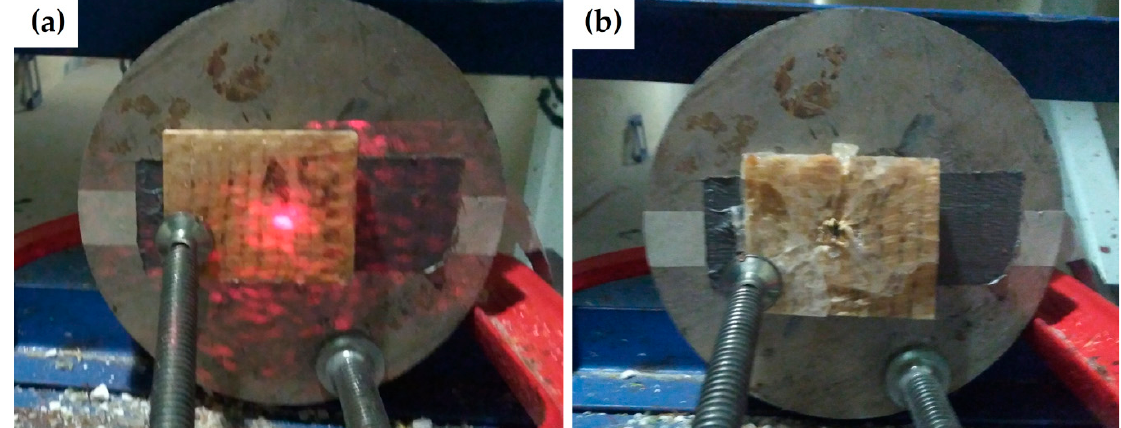
Figure 4. Typical stand-alone ballistic test: ( a ) before shooting, laser beam indicates the direction of 7.62 mm projectile with target plate clamped to a round metallic block; and ( b ) after shooting, there is perforated hole at the center of the plate.